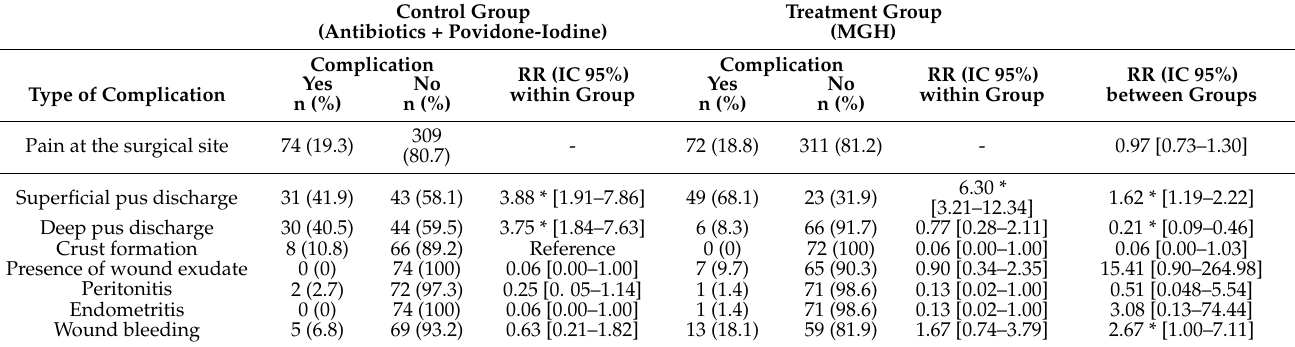
Table 3. Overview of the different types of complications that were experienced by the patients presented per group. Both the control and treatment groups consisted of 383 patients, with 74 and 72 patients considered to have postoperative complications, respectively. Subgroups were based on the presence or absence of postoperative complications. Experiencing pain was a prerequisite, and therefore, the total number of patients with complications and patients experiencing pain are similar. Multiple complications were possible per patient. * represents a significant difference ( p <